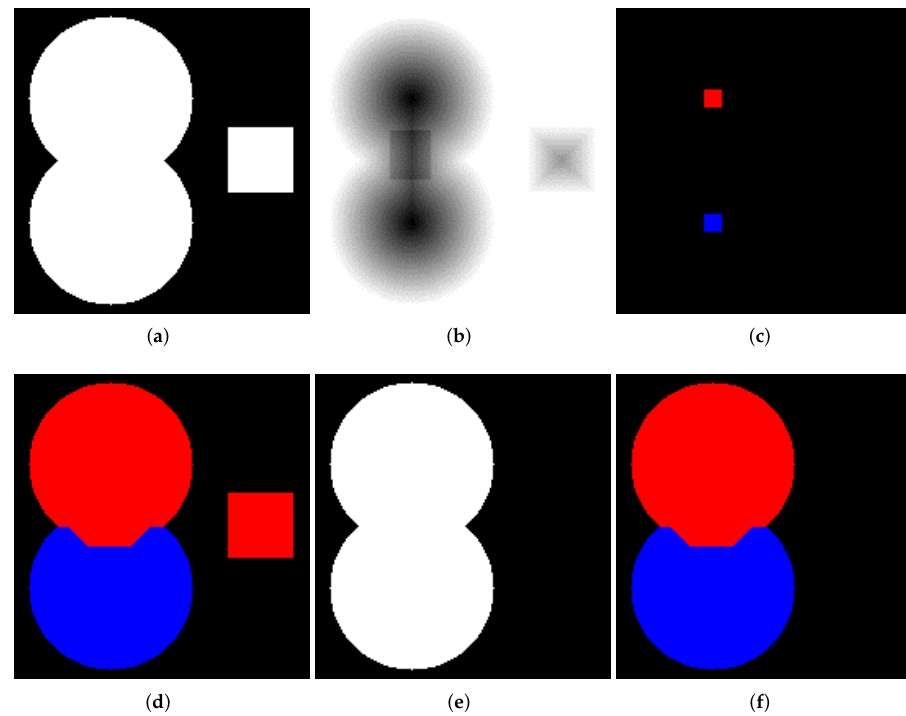
Figure 5. ( a ) Two overlapping discs and a square; ( b ) a relief based on modified result of Euclidean distance transform of image from ( a ); ( c ) initial markers; ( d ) result of the watershed without mask considering; ( e ) mask; ( f ) result of the watershed operated only inside given